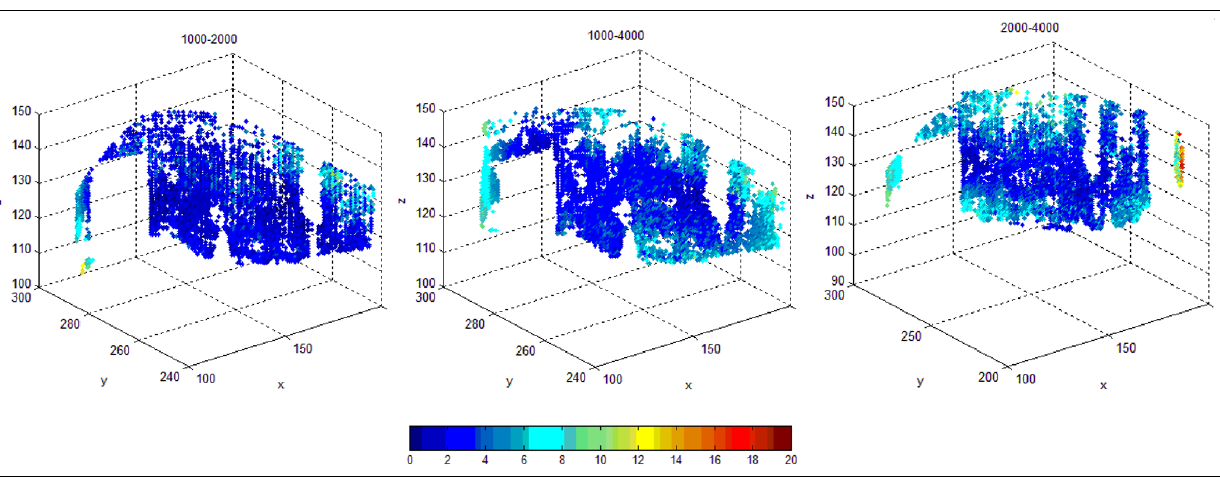
Figure 6. Distance discrepancies of representative points between two scans in epoch 4 (fine registration with seven-parameter transformation)(mm) (the left figure means the variations of distance discrepancies between station 1000 and station 2000 ; the middle one is the variations of distance discrepancies between station 1000 and station 4000 ; the right figure denotes the variations of distance discrepancies between station 2000 and station 4000